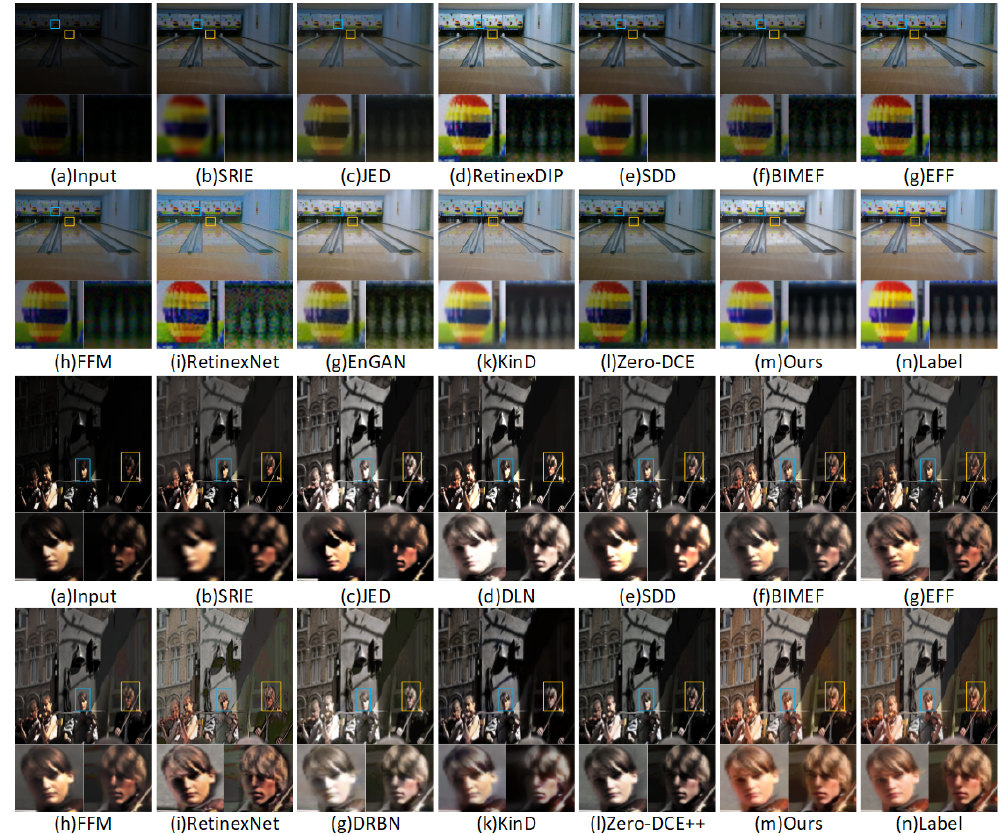
Figure 8. Example of comparison with 14 low-light image enhancement methods on the LOL [1]